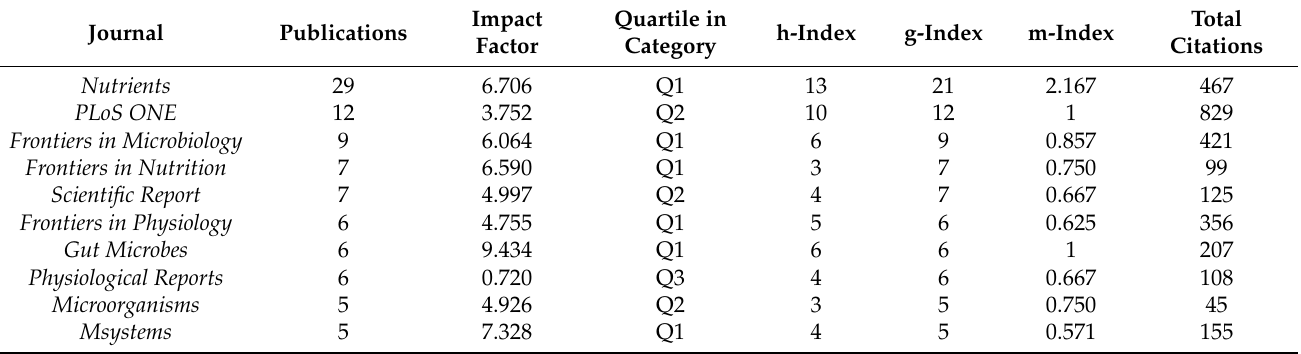
Table 4. Top ten journals with the most publications in the field of the gut microbiome and